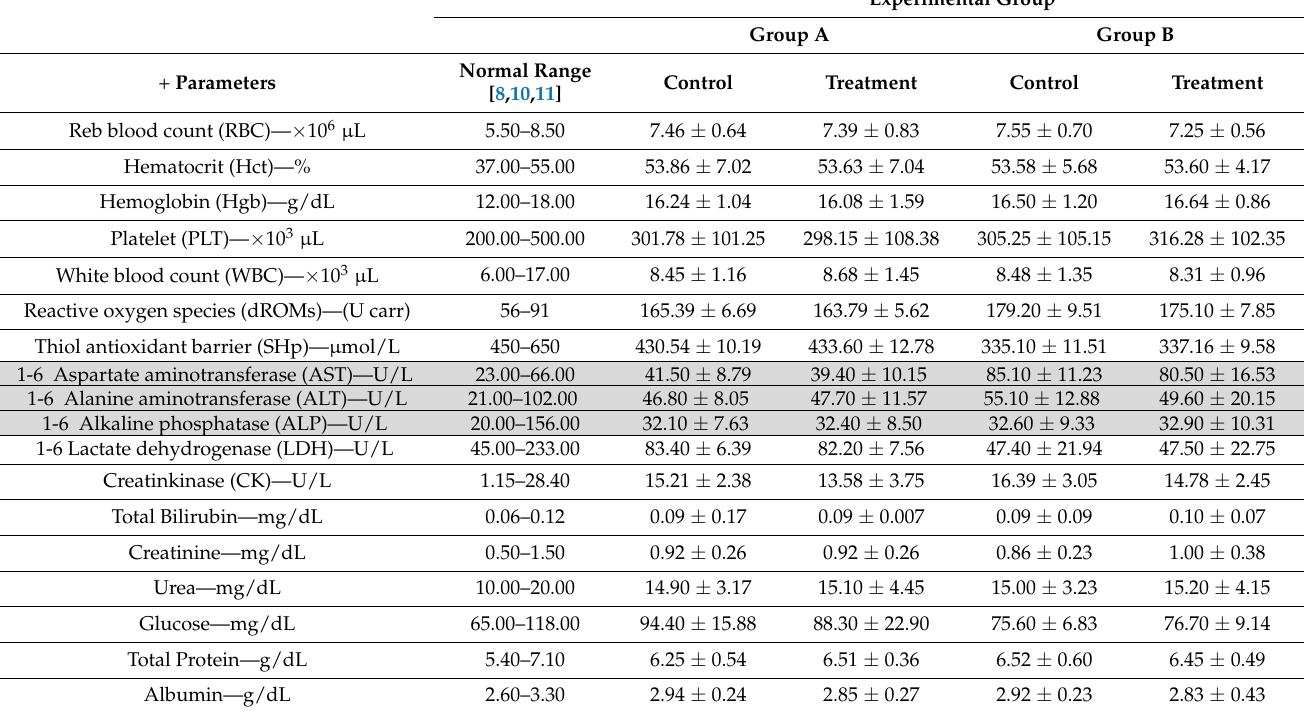
Table 1. Blood screening performed during the pre-enrollment check. Hematological parameters (red blood count—RBC, hematocrit—Hct, hemoglobin—Hgb, platelet—PLT and white blood count— WBC); reactive oxygen species (dROMs), thiol antioxidant barrier (SHp), serum liver enzymes used as inclusion criteria (aspartate aminotransferase—AST, alanine aminotransferase—ALT; alkaline phosphatase—ALP) are shown using grey bars, and serum lactate dehydrogenase (LDH),